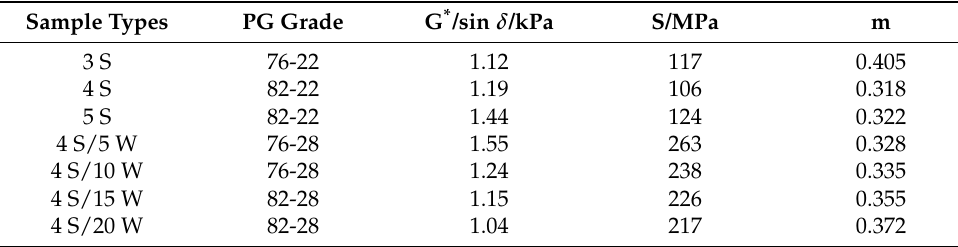
Table 5. The PG grading of WPU/SBS composite modified